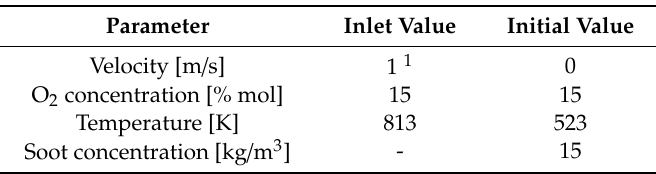
Table 2. Simulation conditions.